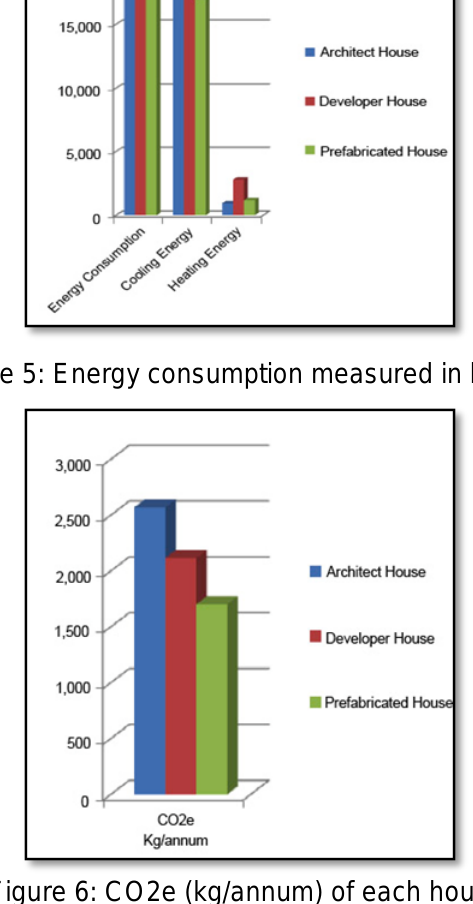
Figure 6: CO2e (kg/annum) of each